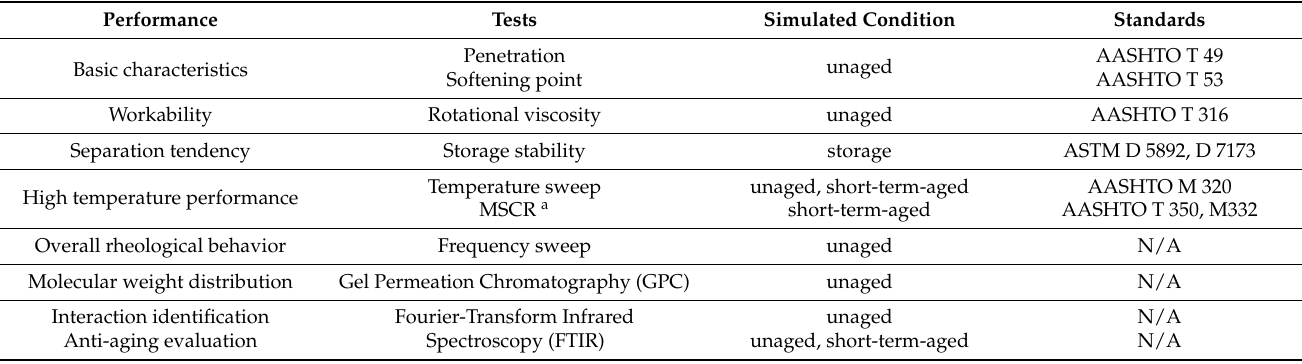
Table 1. Experimental